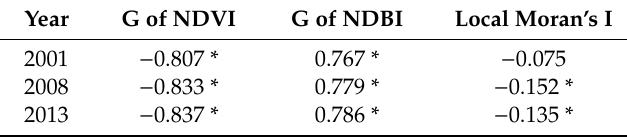
Table 1. Spearman’s rho between LST and the spatial autocorrelation indices for 2001, 2008, and 2013. Year G of NDVI G of NDBI Local Moran’s I